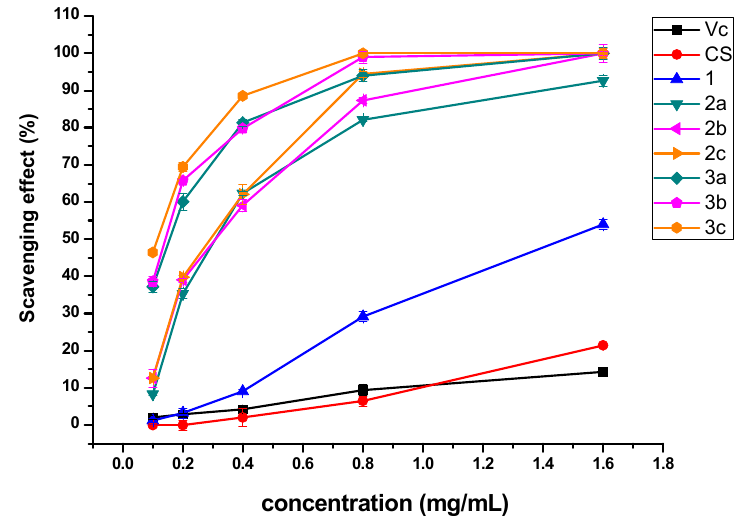
Figure 6. Hydroxyl-radical scavenging activity of chitosan and chitosan derivatives.